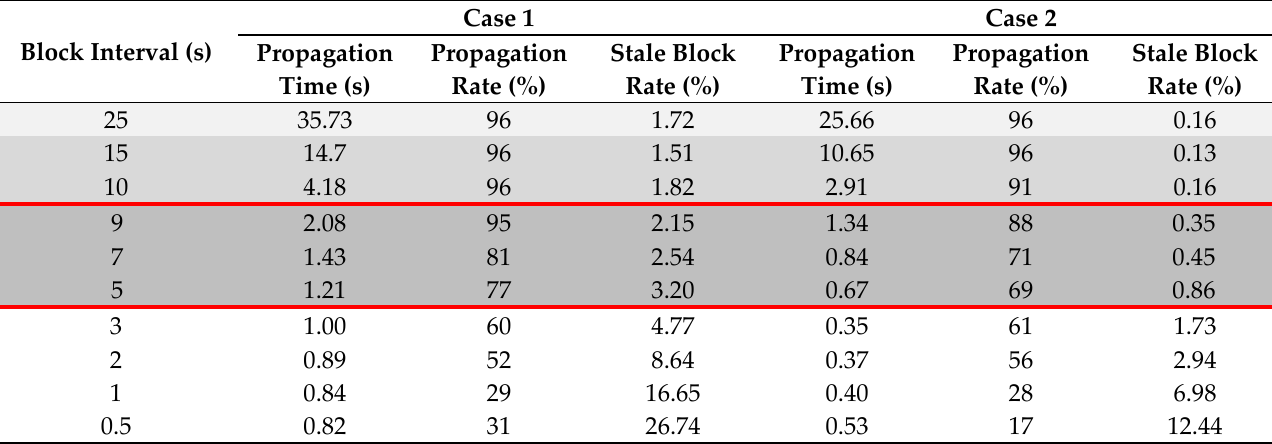
Table 6. Impact of Block Interval on Median Block Propagation Time and Stale Block Rate.